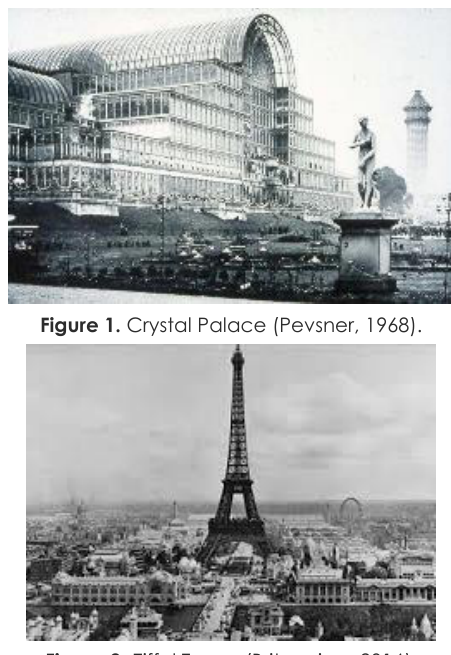
Figure 2. Eiffel Tower (Britannica,